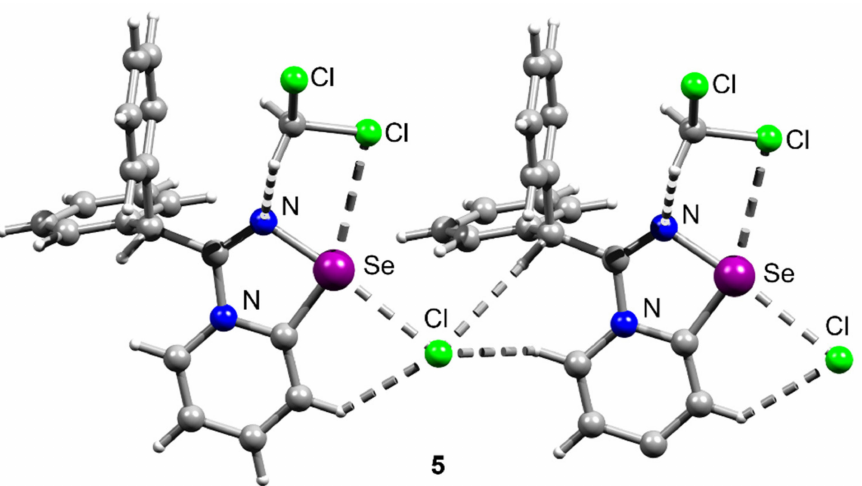
Figure 4. Ball-and-stick representation of the crystal structure of 5 , demonstrating its self-assembly into 1-D supramolecular polymer via Se ··· Cl and H ··· Cl interactions and ChB interactions with a cocrystallized CH 2 Cl 2 molecule. Green, purple, blue, grey, and light-grey spheres represent chlorine, selenium, nitrogen, carbon, and hydrogen,